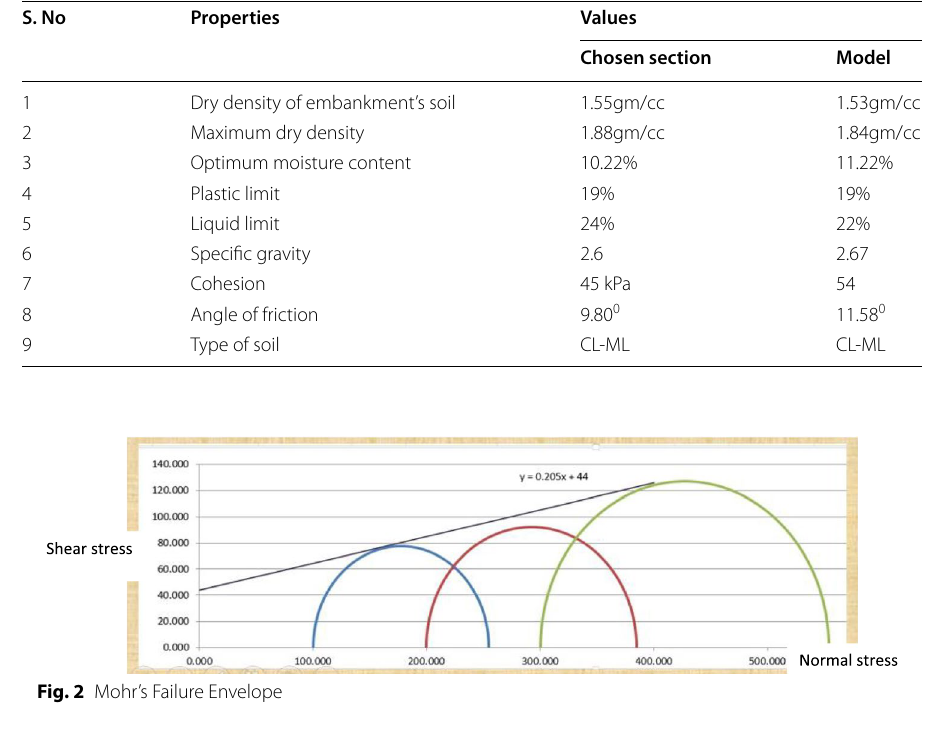
Table 2 Properties of soil derived from chosen section and one used in making model